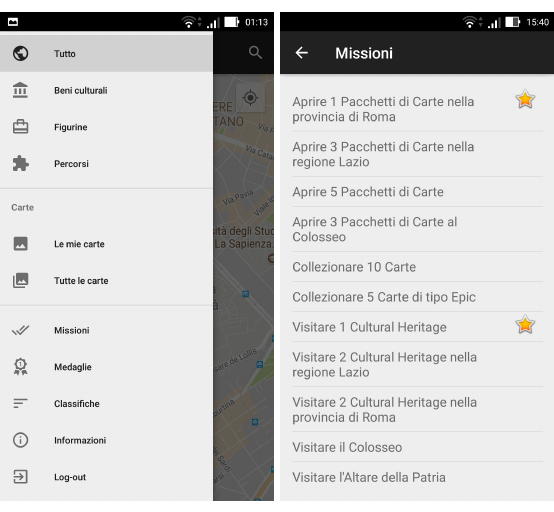
Figure 4. Mysterious paths mini-game